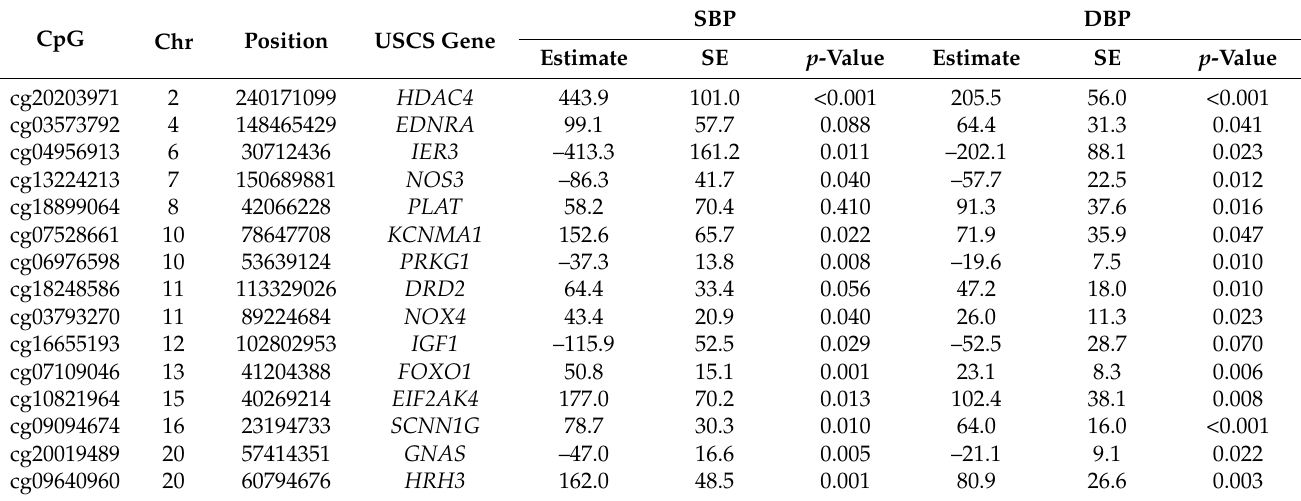
Table 2. Estimated associations between BP measures and the most significant CpG sites mapped with biomarker genes for high